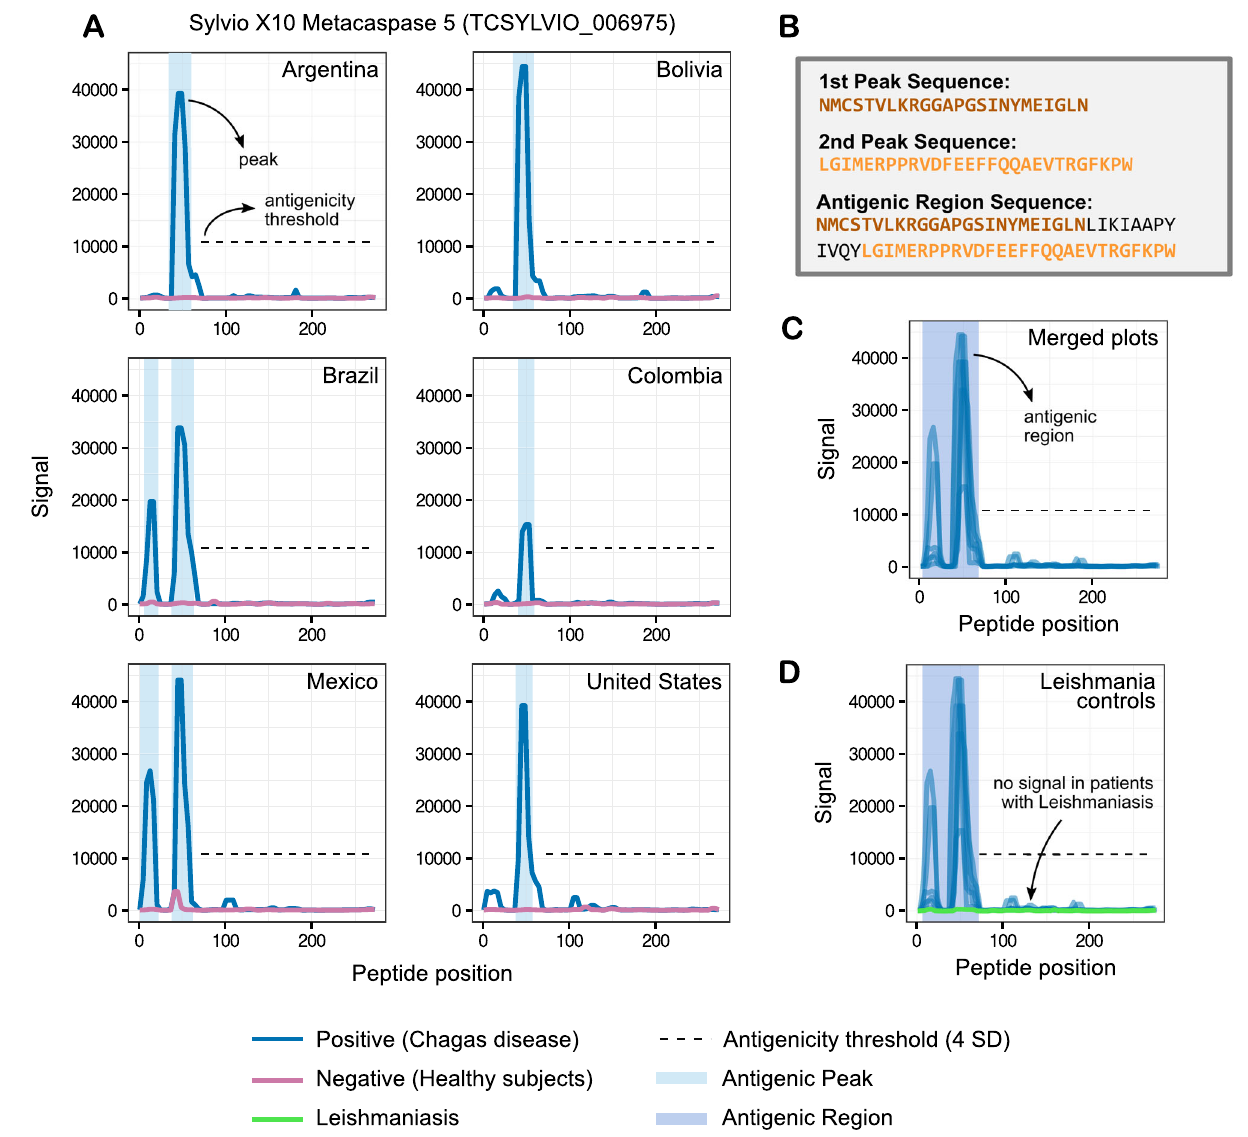
Fig. 2 | Antibody-binding pro fi les, peaks, and regions. The normalised fl uores- shows peptide positions along the protein sequence. Each subplot was produced using data from 4 high-density peptide arrays (2 replicas for Chagas disease sub- jects and 2 for matched healthy subjects, see main text). The fi gure serves to illustrate how we de fi ned peaks (groups of consecutive peptides over the signal threshold) and antigenic regions (groups of neighbouring peaks). A Reactivity